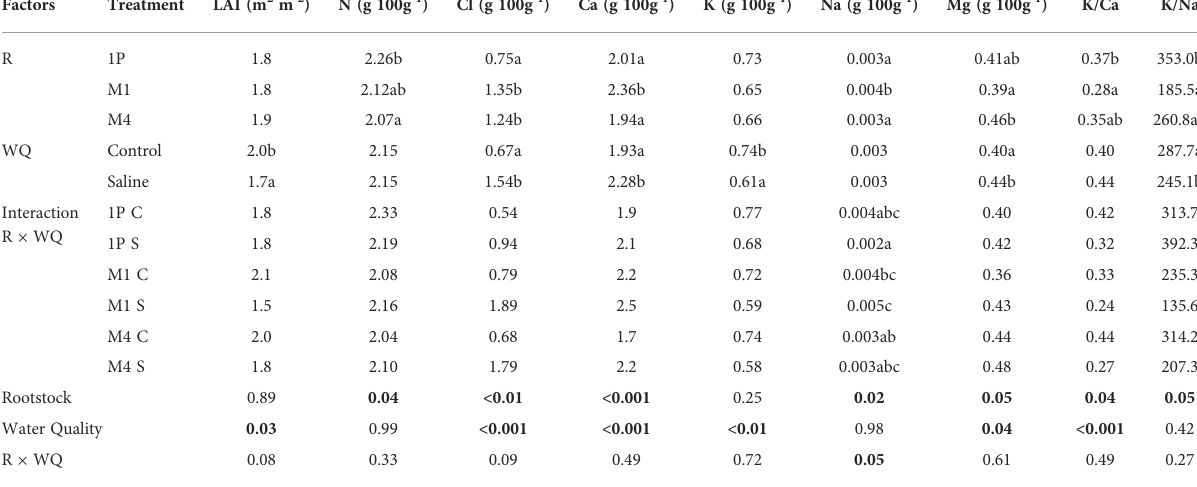
TABLE 2 Leaf area index (LAI) and leaf nutritional status in leaf blades from Vitis vinifera (L.) cv. Tempranillo grafted onto M1, M4 and 1103- Paulsen (1P) rootstocks subjected to different water quality (C; control and S; saline irrigation) on DOY 233 of 2019 in Valencia, Spain.